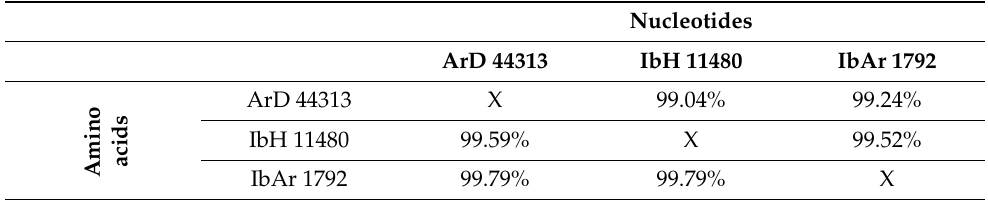
Table 1. N protein homologies of known DUGV